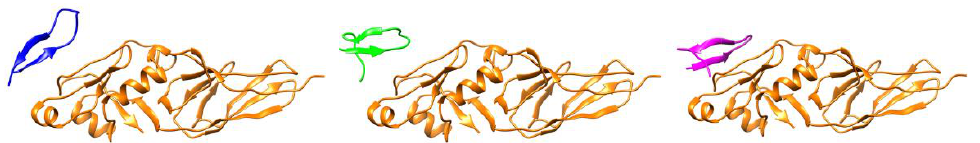
Figure 2. The obtained models with the FlexPepDock program for the analogous peptides 1 ( blue ), 2 ( green ), and 3 ( magenta ) interact with the structure of the Intimin protein.